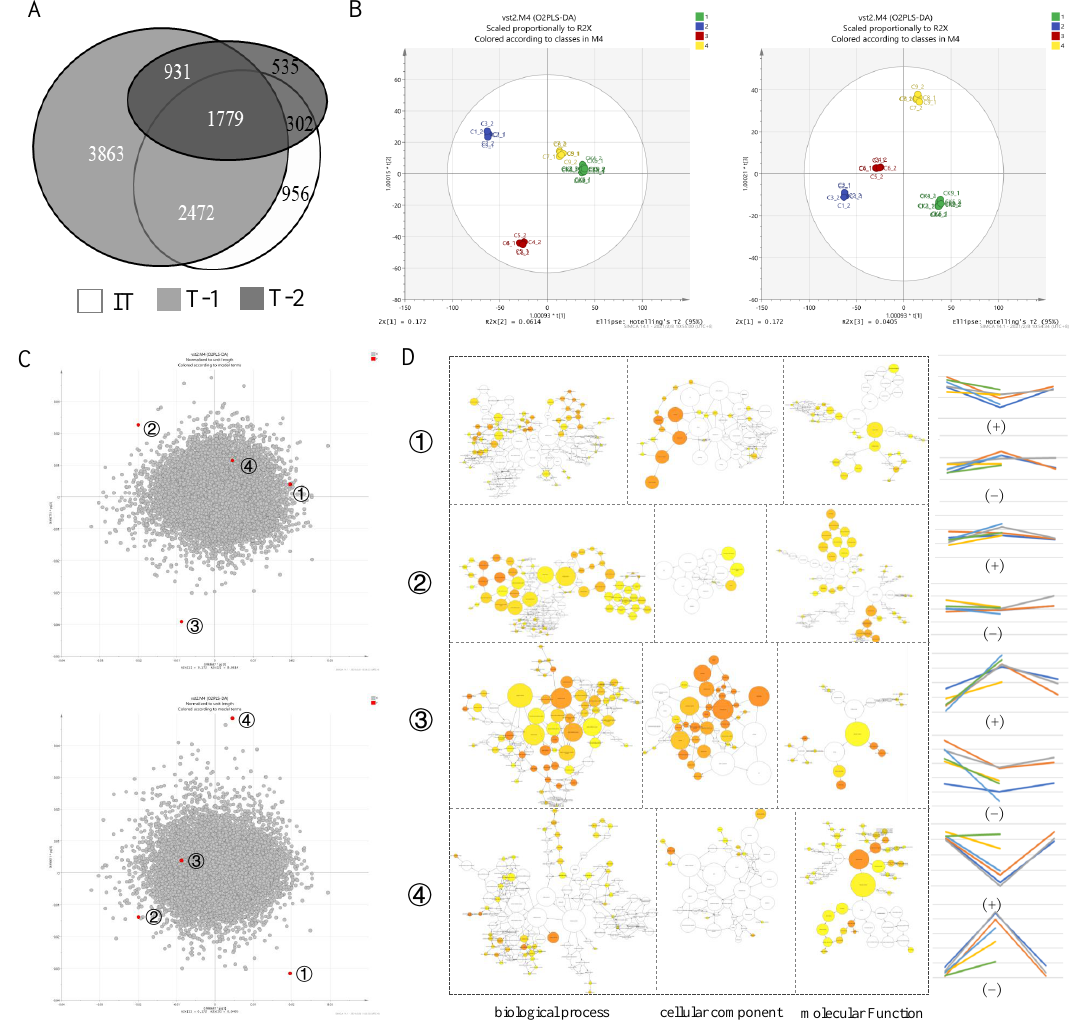
Figure 4. ( A ) . Numbers of differentially expressed genes in grape rootstocks grown under salt stress. IT, genes from three intolerant grape rootstock varieties in first stress period; T1, genes from three tolerant grape rootstock varieties in first stress period; T2, genes from three tolerant grape rootstock varieties in second stress period. ( B ). Partial least squares discriminant analysis (PLS − DA) model of the different samples made by SIMCA to analyze the scatter diagram; 1, 2, 3, and 4 represent CK, the two stages of tolerant varieties, and one stage of the intolerant varieties. ( C ): The o2PLS − DA load graph produced by SIMCA. ( D ): DEGs expression patterns and GO enrichment analysis. The right-hand diagram (+) ( − ) represents the positive correlations and negative correlations, and the line graph represents the expression trend in the